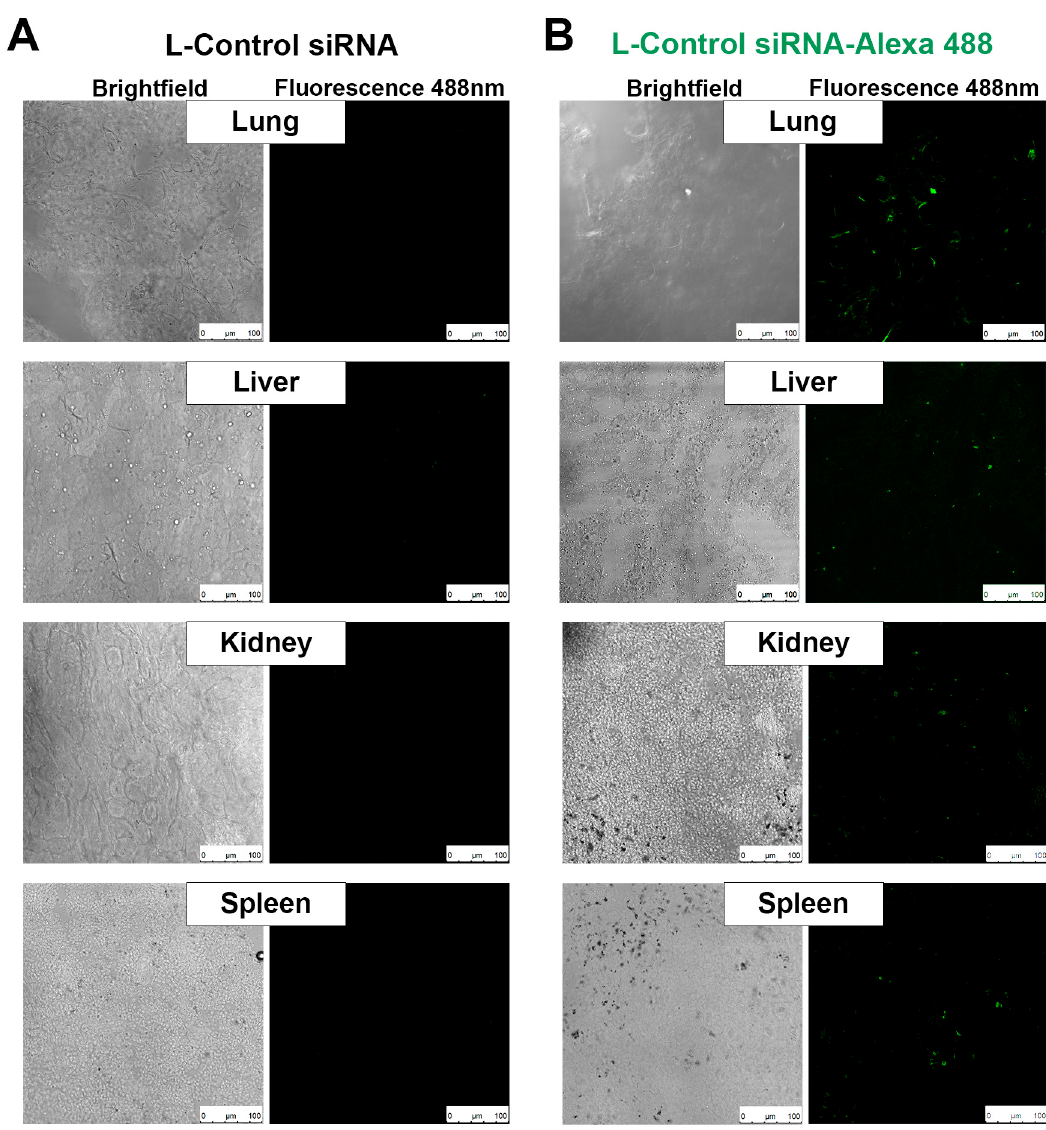
Figure 3. Respiratory delivery of liposomal siRNA biodistribution assay. Frozen sections of different tissues after 1 h treatment with ( A ) L-Control siRNA or ( B ) L-Control siRNA with fluorescent mark for Alexa 488 (in green). Comparison of brightfield and fluorescent images showing the lungs as the organ with the highest intensity of signal after the administration of respiratory L-siRNA. Scale bars represent 100 µm.